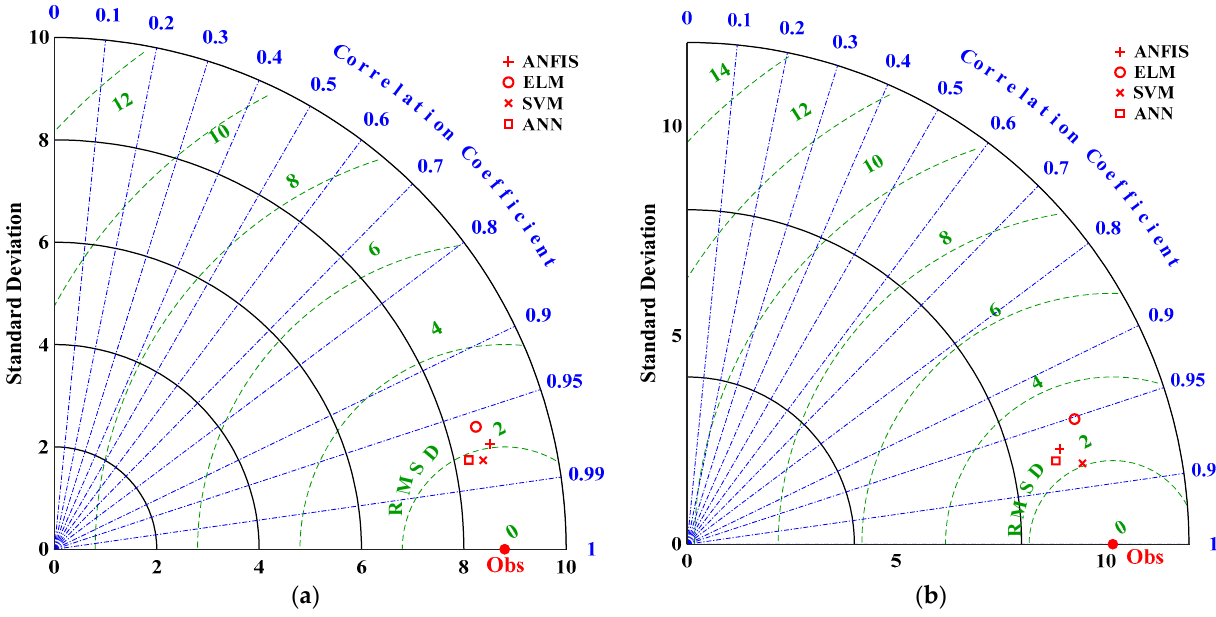
Figure 12. Taylor diagram comparing the overall model’s performance for ( a ) training and ( b ) testing phase.